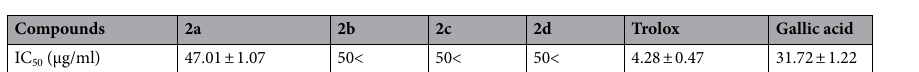
(Table 2). On the other hand, there is not much difference between percent inhibition values for the compounds. This means that the position of functional groups as ortho ‑ , para- or meta ‑ has a slight effect on the antioxidant